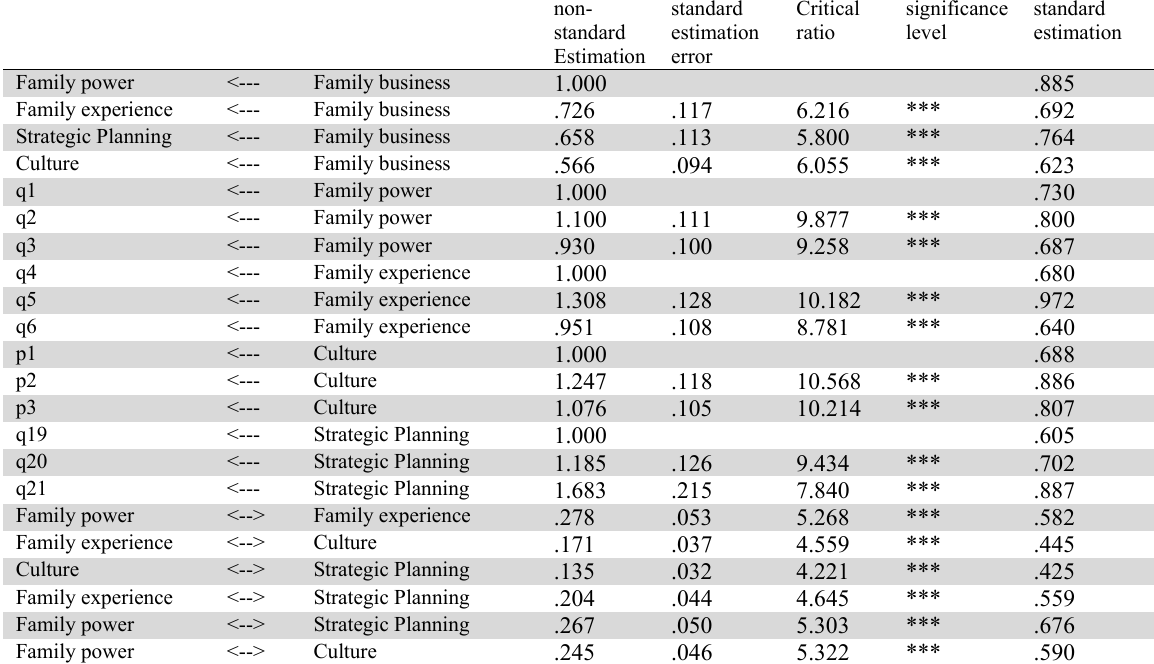
Estimation Indicators of Research model after